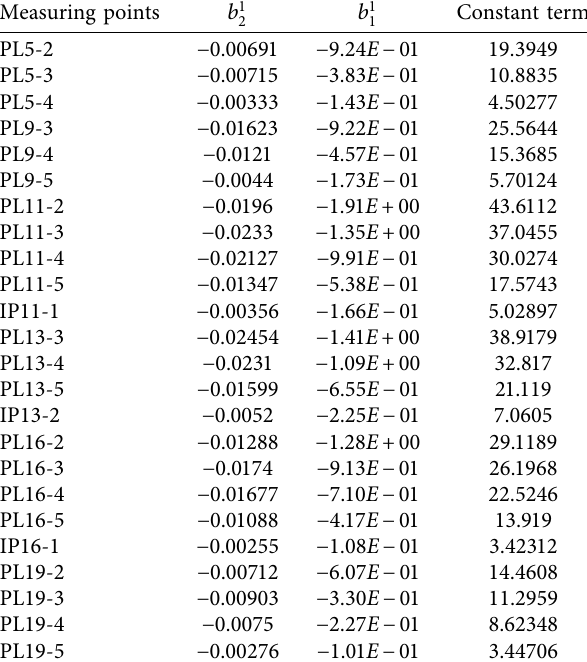
Table 2: Coefficients b 1 i and the constant term fitted by simulation results of the finite element model.